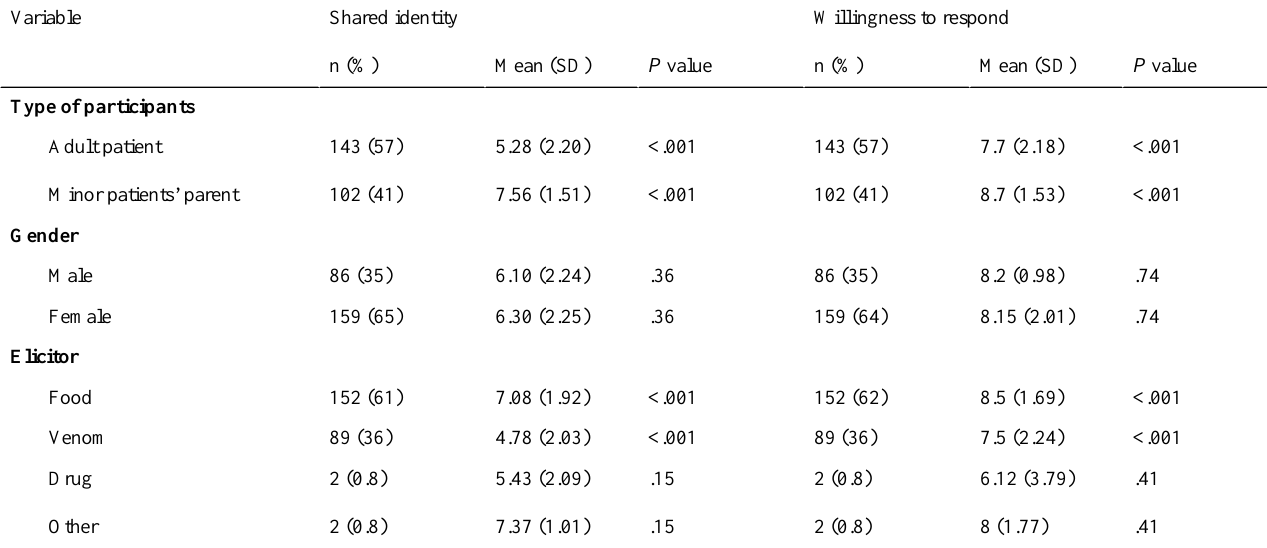
Table 4. Results of t testing for shared identity and willingness to respond according to participants’characteristics.